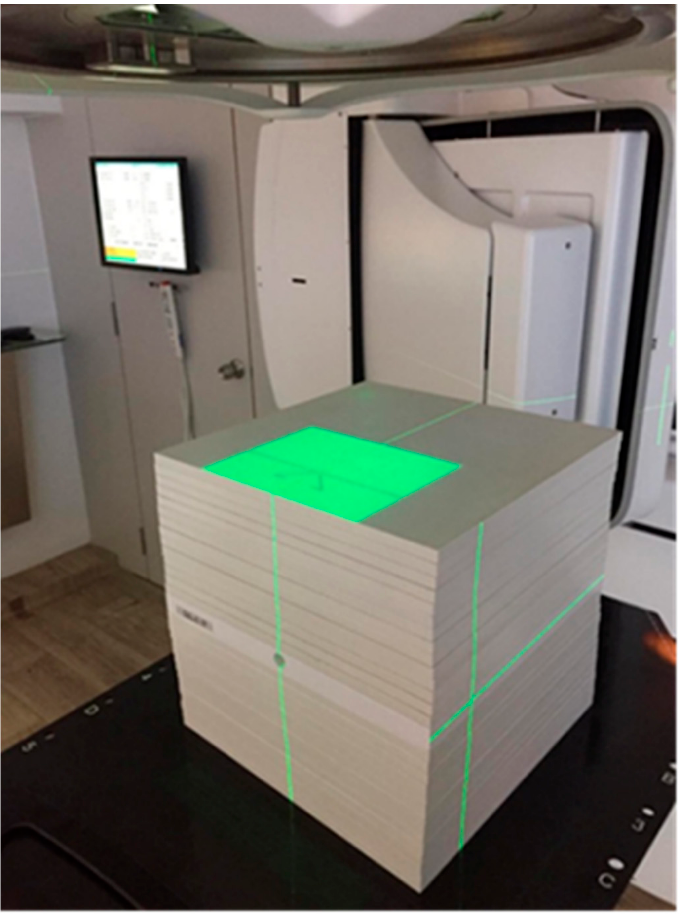
Figure 1. Picture of the 30 × 30 × 30 cm 3 RW3 slab phantom incorporating the blood tube.